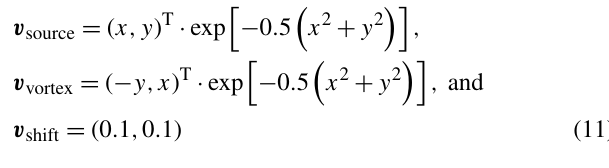
Figure 2. Output vector fields (a) , as well as the corresponding divergence (b) and curl (c) using the natural Helmholtz–Hodge de- composition of the synthetic vector field from Eq. (11); cf. Fig. 1 for a grid size of δs = 1 /